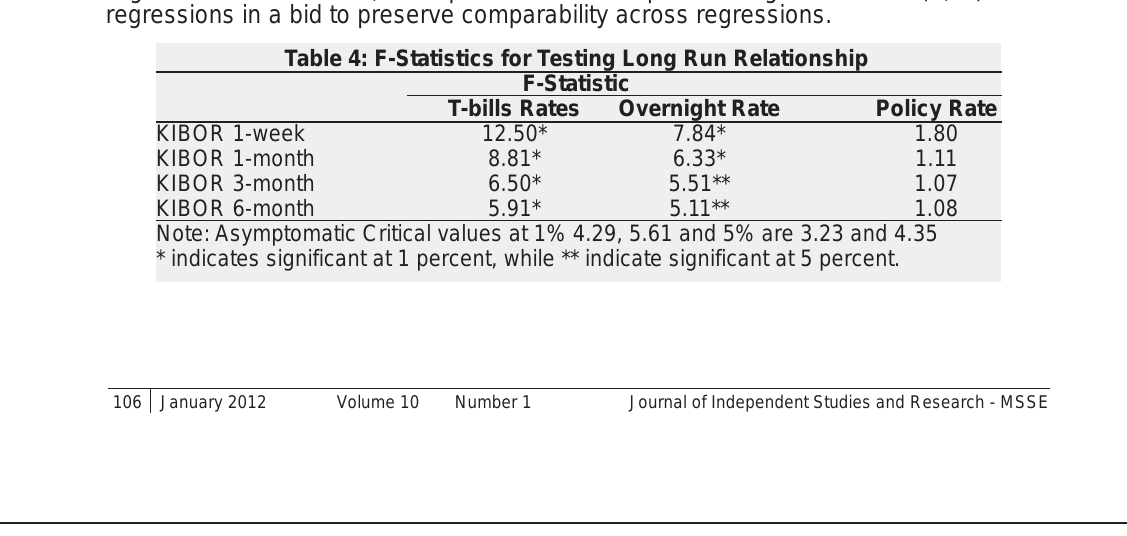
Table 4: F-Statistics for Testing Long Run Relationship